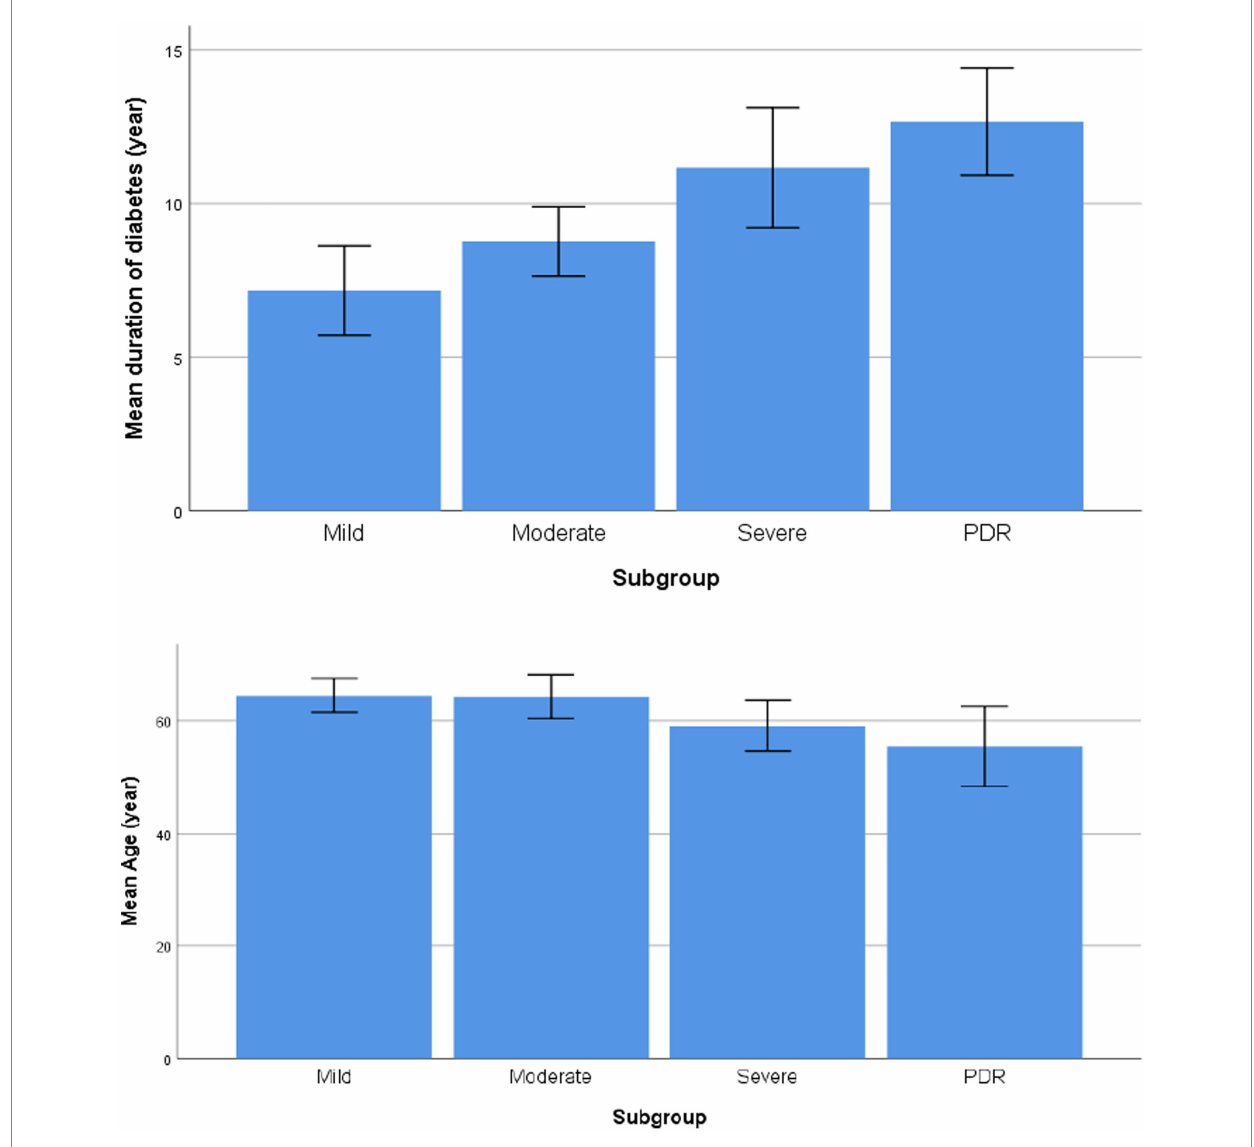
FIGURE 1 Comparison of the duration of diabetes and age between the groups with different degrees of NPDR and